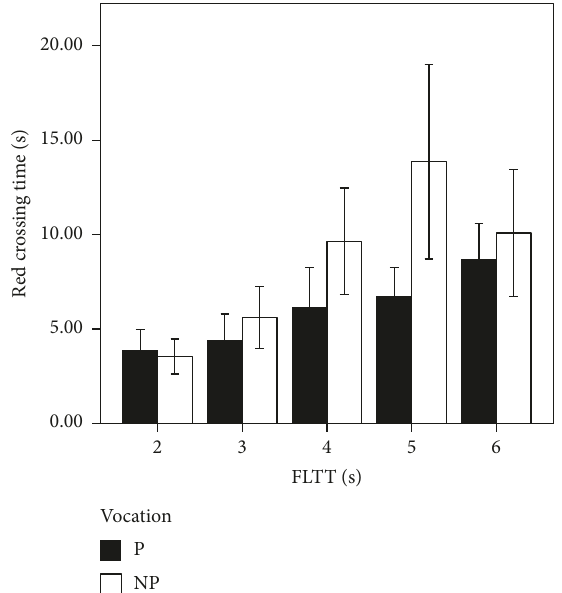
Figure 15: Mean RCT for the interaction between FLTT and vocation.